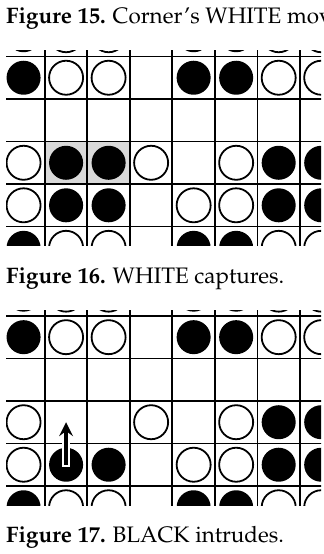
Figure 17. BLACK intrudes.